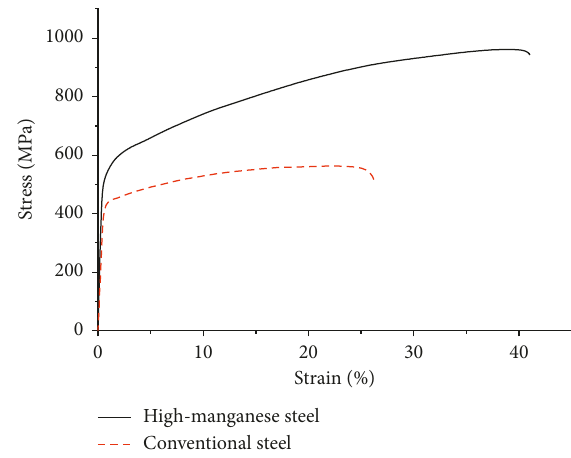
Figure 1: The stress-strain curve of reinforcing